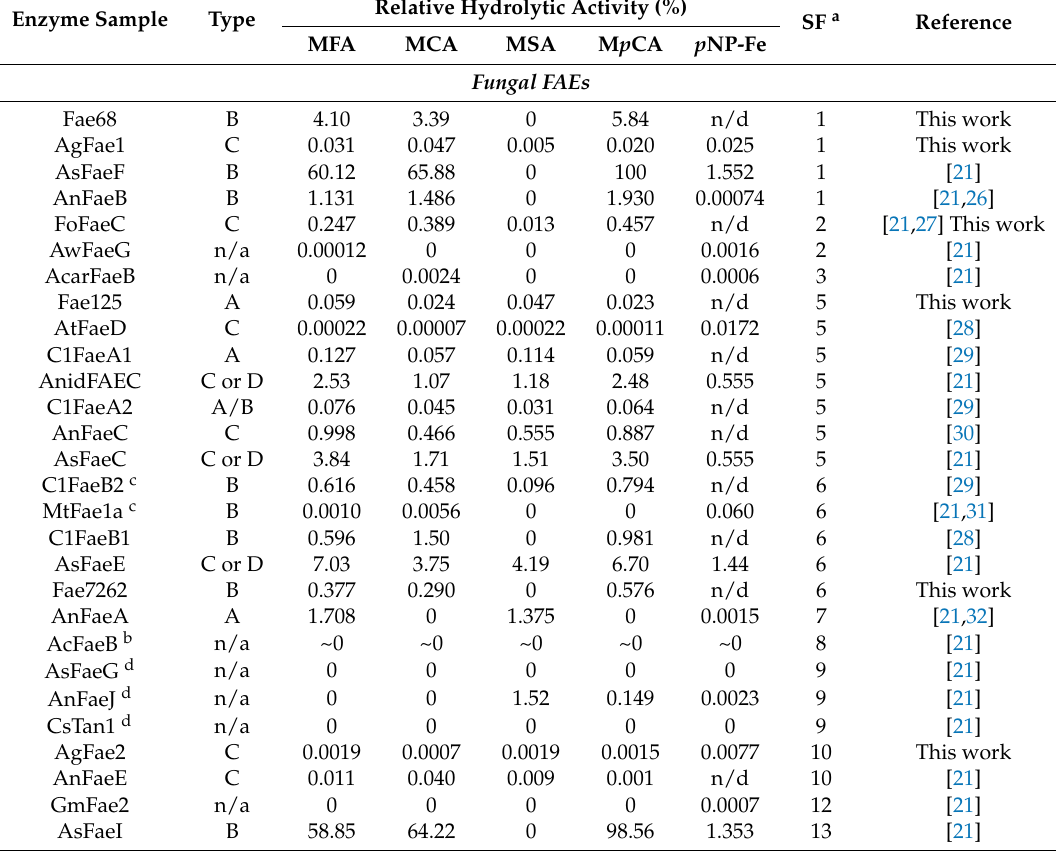
Relative hydrolytic activity (%, determined as U mg − 1 protein) of FAEs against hydroxycinnamic acid